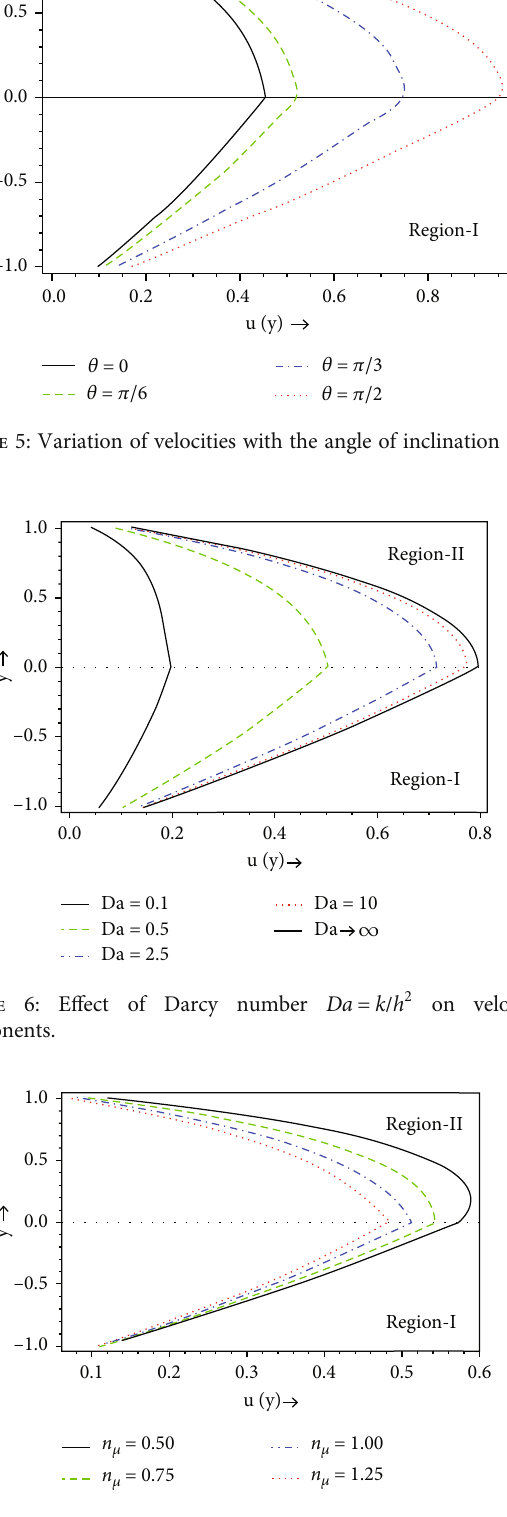
Figure 7: E ff ect of viscosity ratio η components.